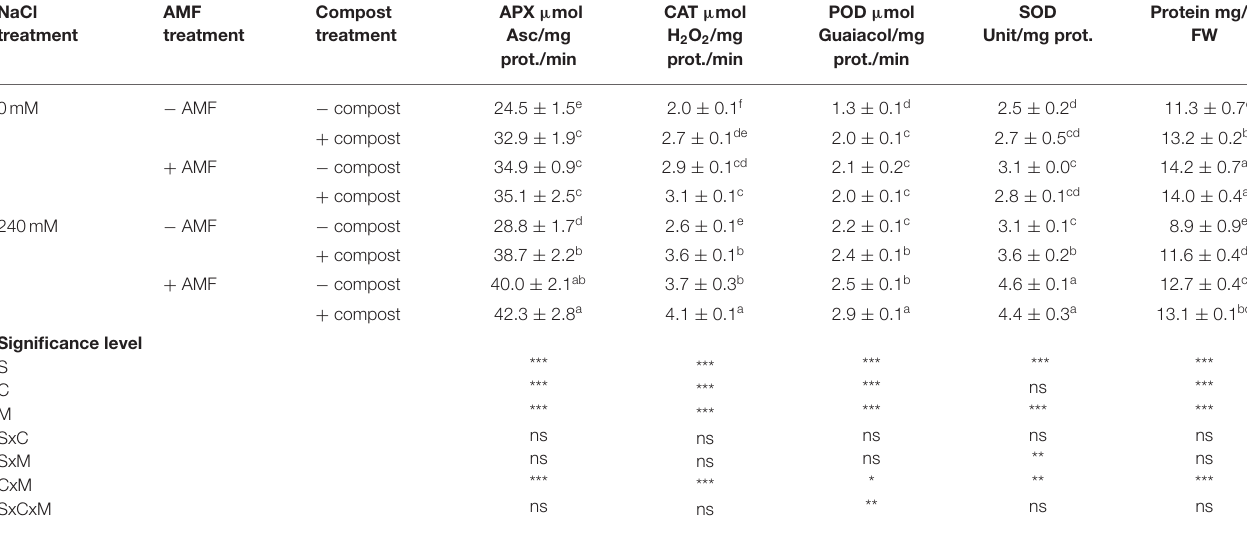
TABLE 6 | Root antioxidant enzyme activity (APX, CAT, POD, and SOD) of date palm plants under saline and non-saline conditions after application of compost and AMF alone or in combination. NaCl